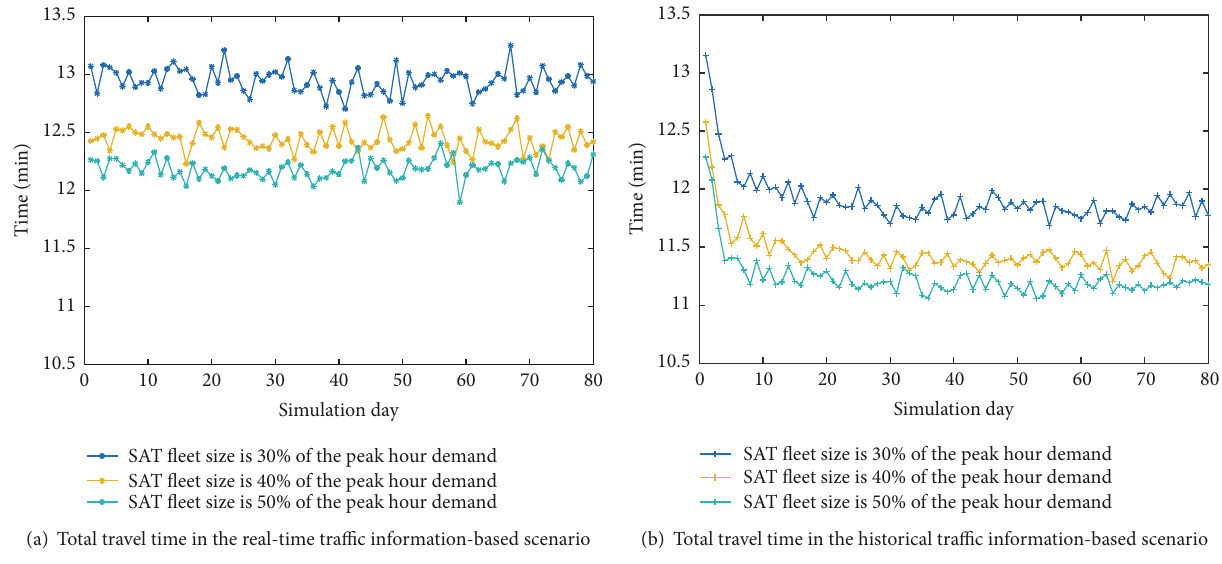
Figure 10: Day-to-day changes in total travel time for taxi requests in SATS with several SAT fleet sizes.